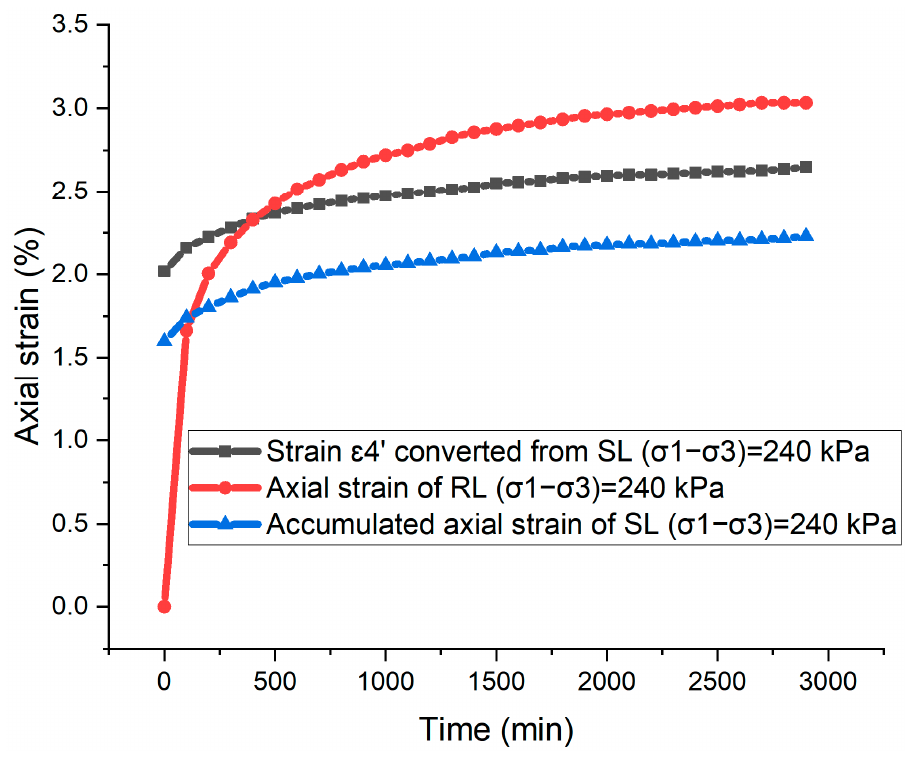
Figure 6. Comparison of converted RL axial deformation and tested RL and SL axial deformation when ( σ 1 − σ 3 ) = 240 kPa (Test 4, 3).